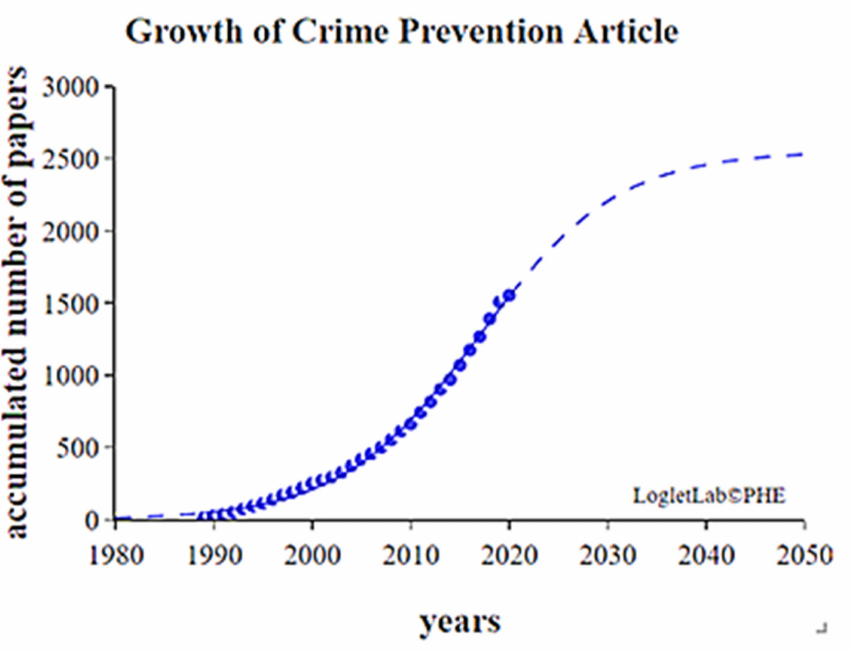
Figure 11. Studies on crime prevention. A growth curve analysis was performed to identify the period of maturity in the research on crime prevention as blue